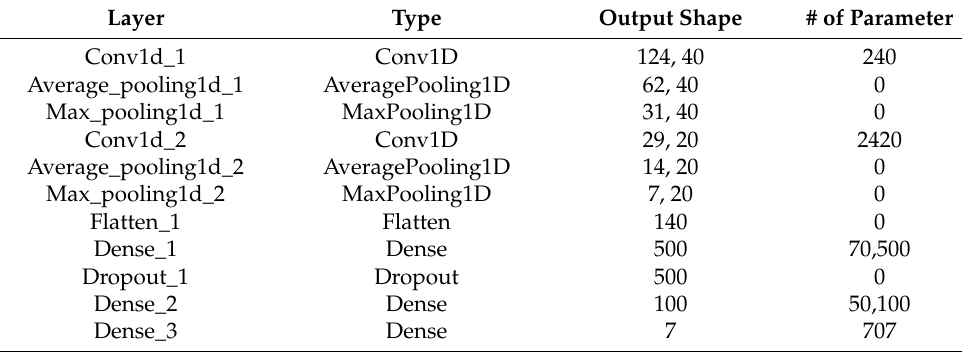
Table 1. Convolutional neural network and